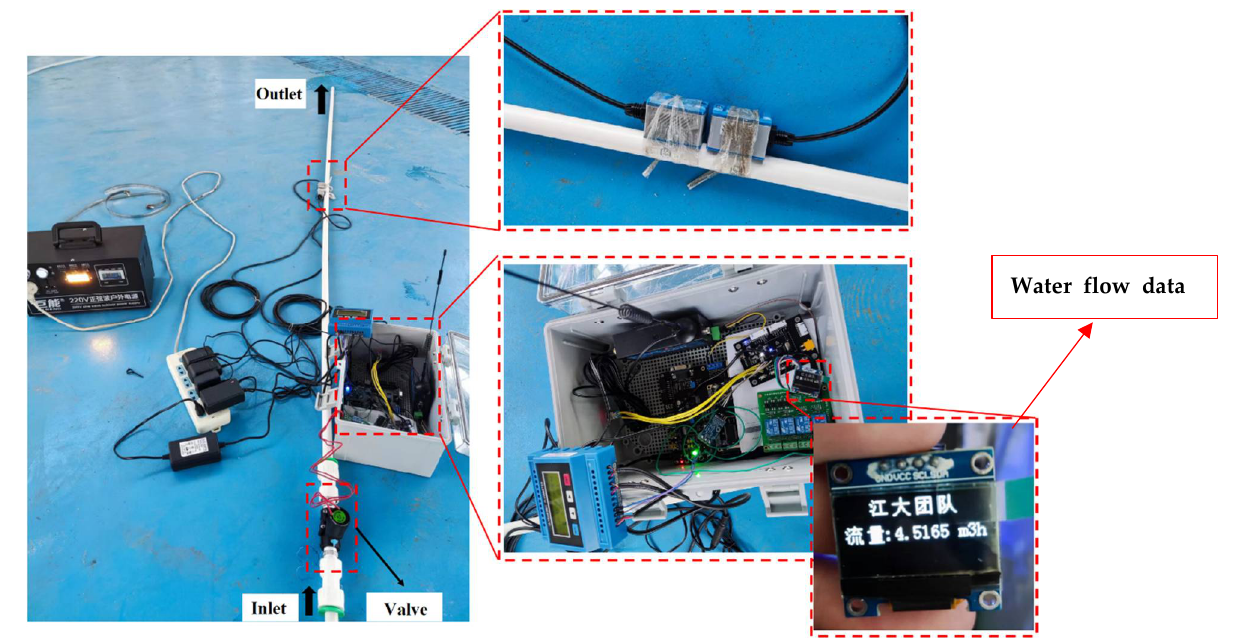
Figure 4 . Spot application test. Figure 4. Spot application